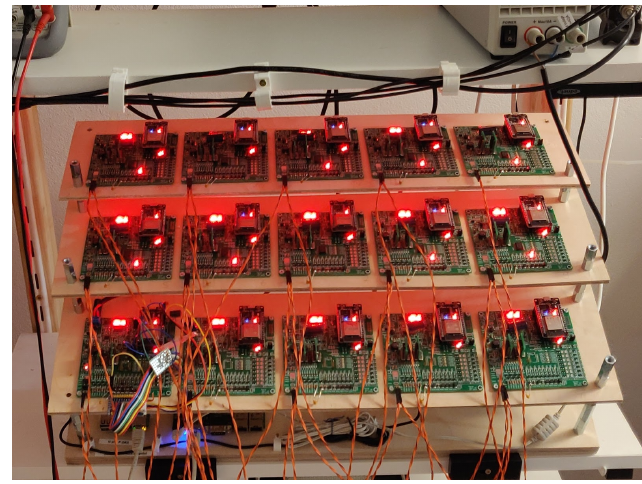
Figure 7. Master and clients in Hardware-In-The-Loop during operation.